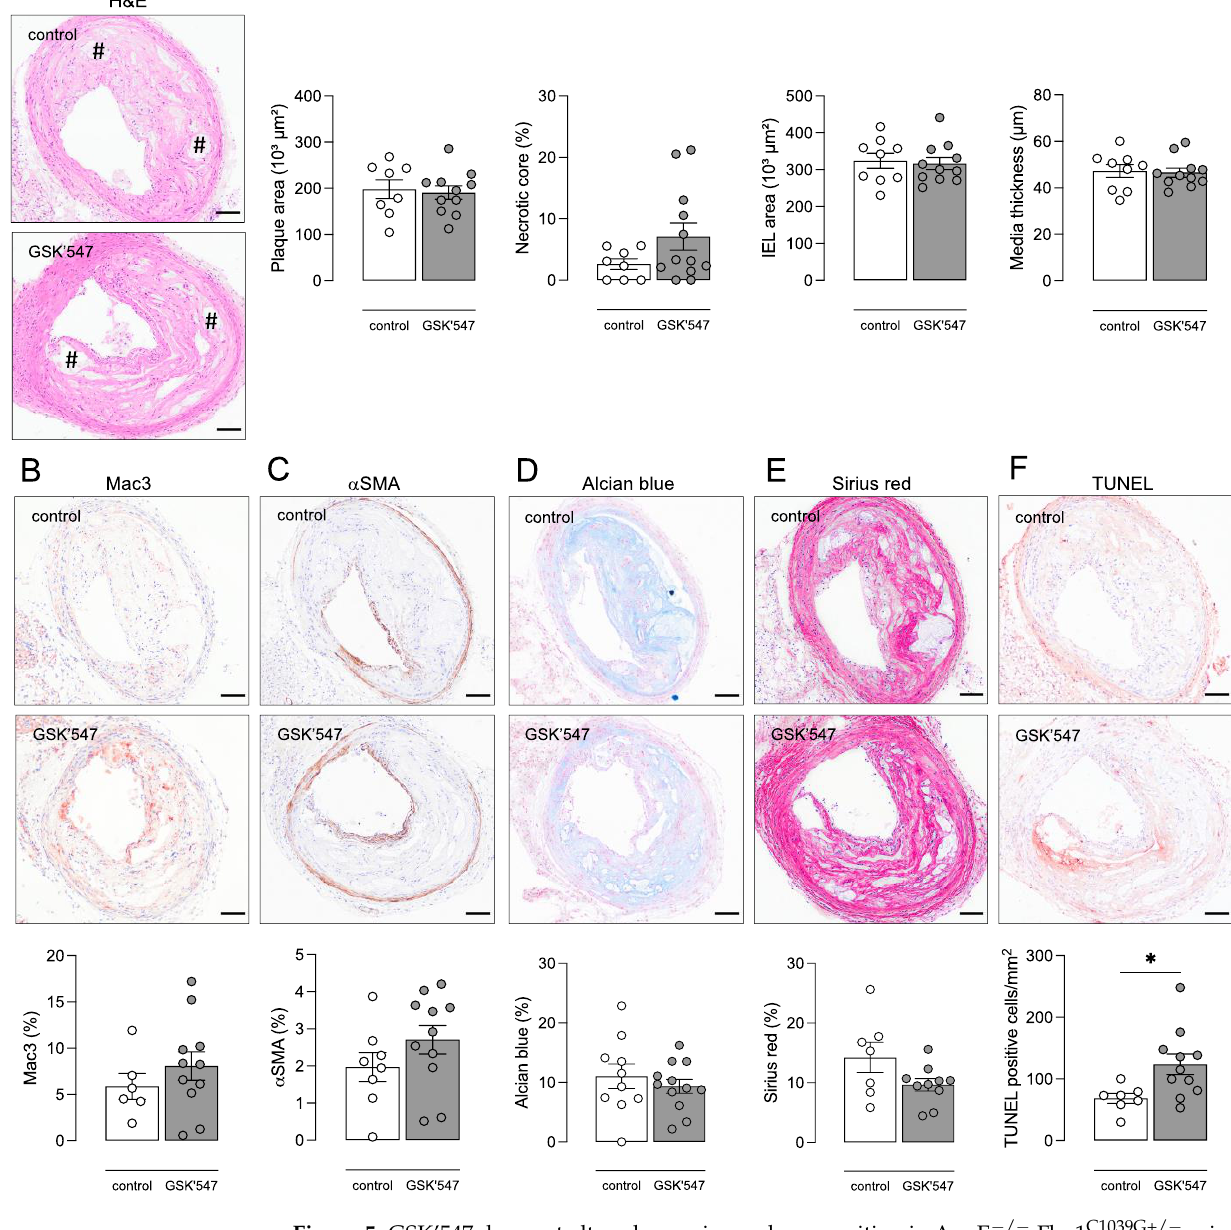
Figure 5. GSK’547 does not alter plaque size and composition in ApoE −/− Fbn1 C1039G +/− mice but increases apoptosis. ApoE −/− Fbn1 C1039G +/− mice were fed a WD supplemented with GSK’547 (10 mg/kg BW/day) for 20 weeks. Sections of the brachiocephalic artery were stained with ( A ) hematoxylin/eosin to measure plaque size, necrotic core (# hash signs), and vessel properties, ( B ) anti-Mac3 to determine macrophage content, ( C ) anti- α -smooth muscle actin ( α SMA) to determine vascular smooth muscle cell content, ( D ) Alcian blue to quantify glycosaminoglycans, ( E ) Sirius red to quantify total collagen, and ( F ) TUNEL to count apoptotic cells. * p < 0.05 (independent samples t -test, n = 8 – 12 mice per group). Scale bar = 100 µm. Representative images are shown.